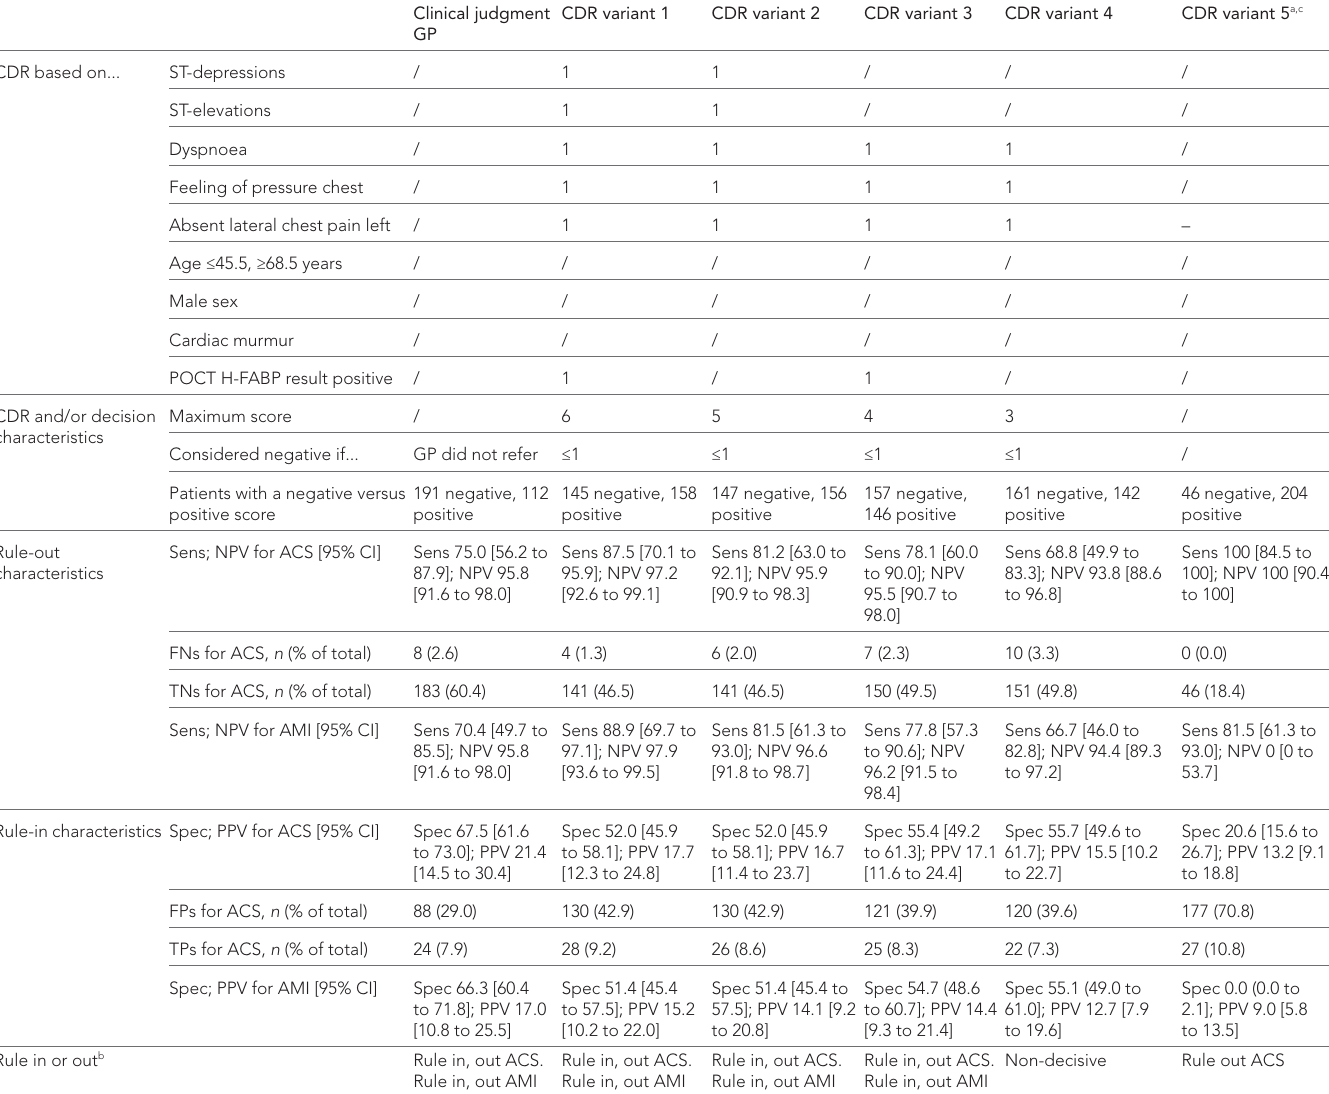
Table 3 Sensitivity and specificity of possible clinical decision rules based on multivariable analyses of the study data (total patients with chest pain analysed, n = 303; total patients with ACS, n = 32 [10.6%]; total patients with AMI, n = 27